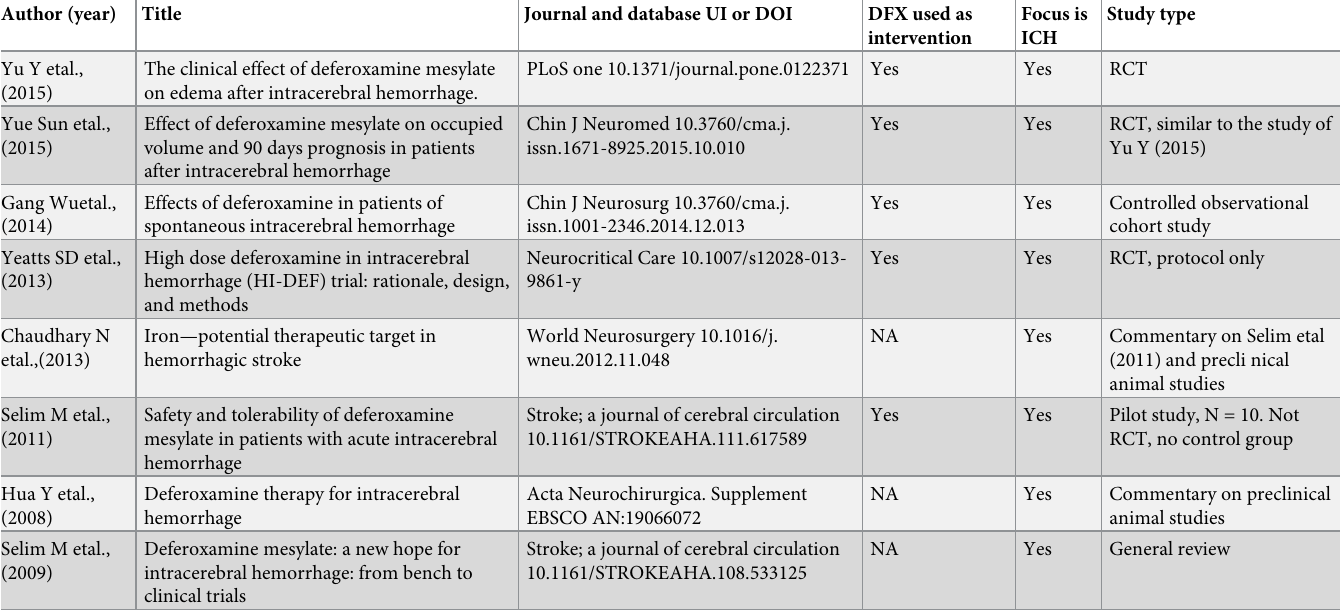
Table 2. Characteristics of the 8 studies for full-text review. Author (year) Title